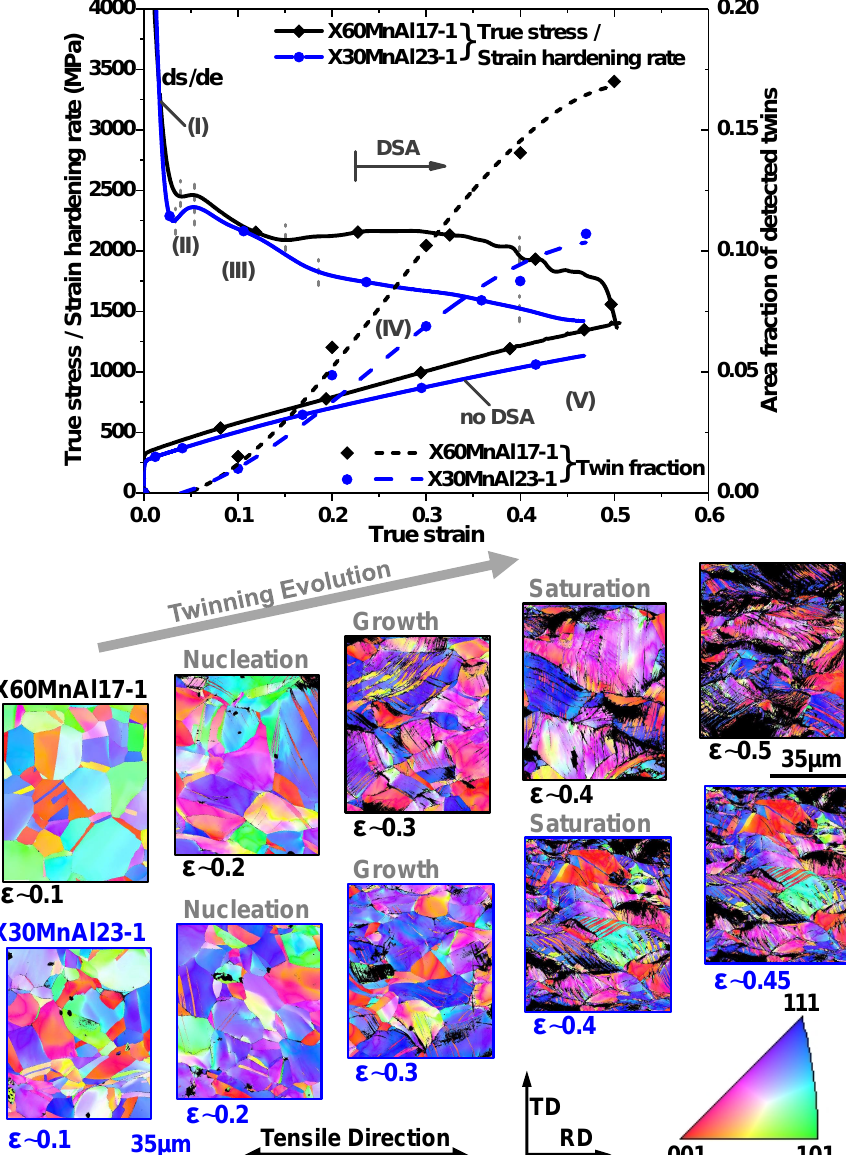
Figure 13. Strain hardening in relation to the evolution of twinning; strain hardening behavior ( top ) and EBSD IPF maps with increasing macroscopic true strain ( bottom